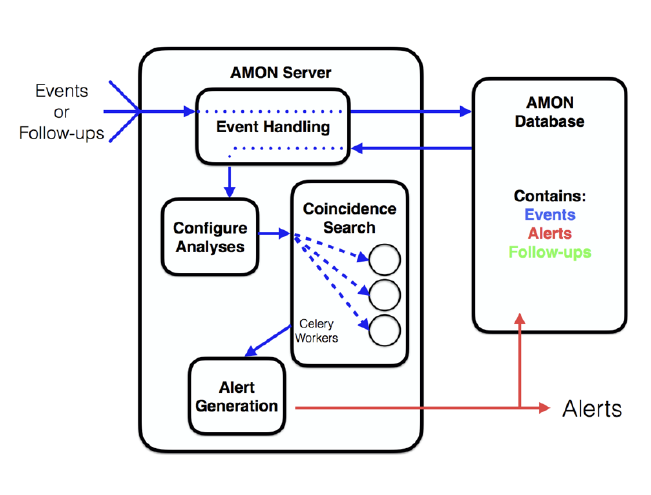
Figure 2. The AMON server. After receiving the events, these are written into the database. Then, they are sent to the Celery workers that are in charge of the coincidence analyses. If a coincidence has high significance, meaning a low false alarm rate (e.g., <1 per year), an alert is generated and sent to